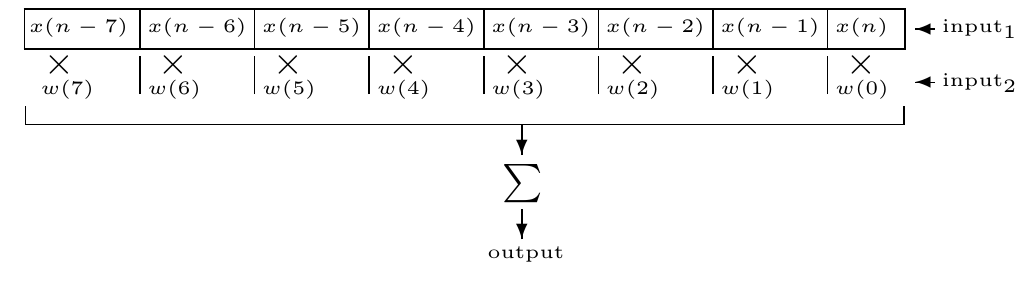
Figure 8. Direct